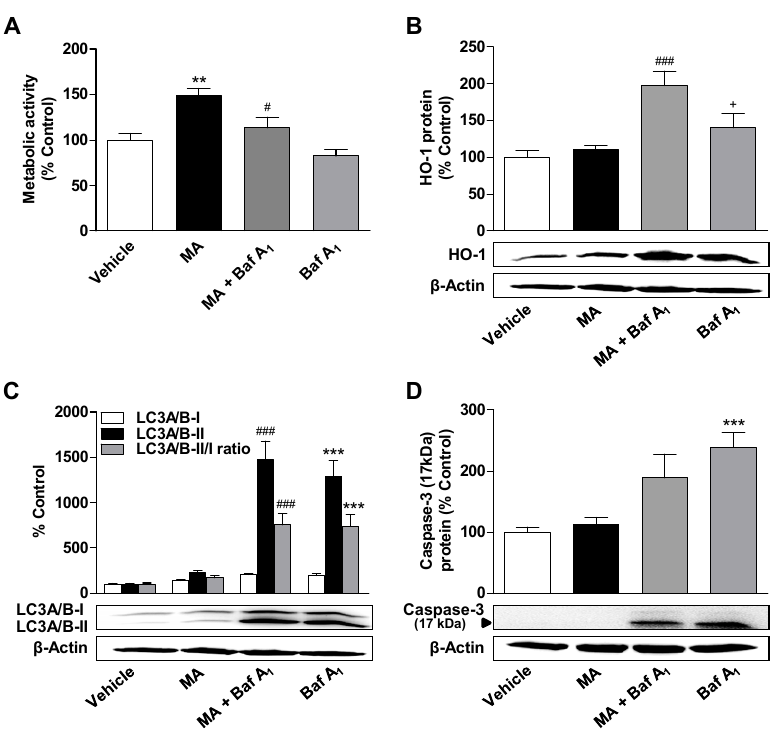
Figure 6. Influence of the autophagy inhibitor bafilomycin A 1 (Baf A 1 ) on the effects of MA on metabolic activity, autophagy, apoptosis, and HO-1 expression. ADMSCs were pretreated for 30 min with bafilomycin A 1 (100 nM) and after subsequent addition of MA (3 µM) or vehicle, the cells were co-incubated with the substances or vehicles for 24 h. Afterwards, the cells were analyzed for metabolic activity ( A ), HO-1 ( B ), and LC3A/B-I/II ( C ) expression as well as caspase-3 cleavage ( D ). The protein expression values were normalized to β -actin. The same actin blot was used as control in ( B , C ), since the proteins analyzed in these Western blots were resolved on the same gel. The percentage control provides a comparison with the vehicle-treated group (set to 100%). The data represent mean values ± SEM of n = 9 ( A , D ) or n = 12 ( B , C ) different donors. ** p < 0.01, *** p < 0.001 vs. vehicle control; # p < 0.05, ### p < 0.001 vs. MA; + p < 0.05 vs. MA + Baf A 1 ; one-way ANOVA with Bonferroni’s post hoc test.